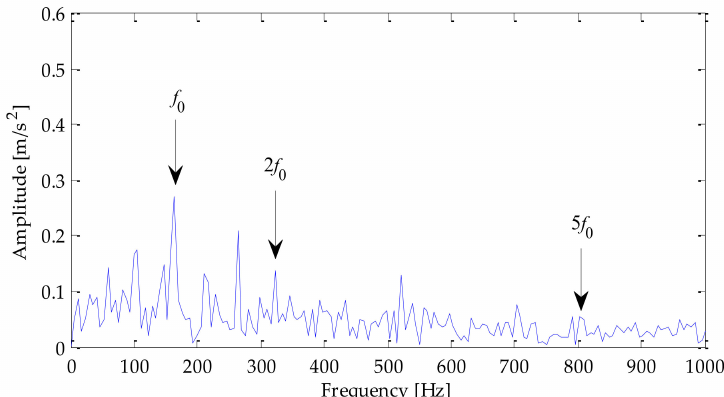
Figure 32. Analysis of signal envelope spectrum after noise reduction based on